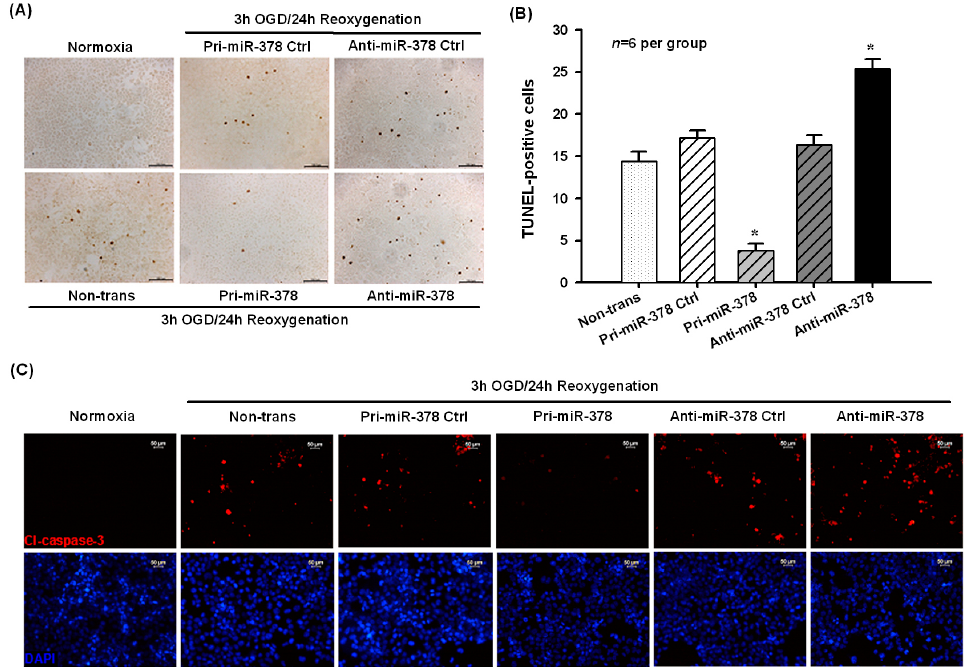
Figure 2. Pri ‐ miR ‐ 378 transfection significantly reduced 3 h OGD/24h reoxygenation ‐ induced N2A cell apoptosis. ( A , B ) Representative TUNEL staining and statistical analysis showed that transfection of pri ‐ miR ‐ 378 significantly attenuated, while anti ‐ miR ‐ 378 increased the number of TUNEL ‐ positive cells, * p < 0.05 vs. OGD non ‐ trans, n = 6 per group; ( C ) Cleaved caspase ‐ 3 staining showed that overexpression of miR ‐ 378 could attenuate OGD ‐ induced neuronal apoptosis, while anti ‐ miR ‐ 378 aggravated N2A cell apoptosis induced by 3 h OGD/24 h reoxygenation. Scale bar = 50 µm.